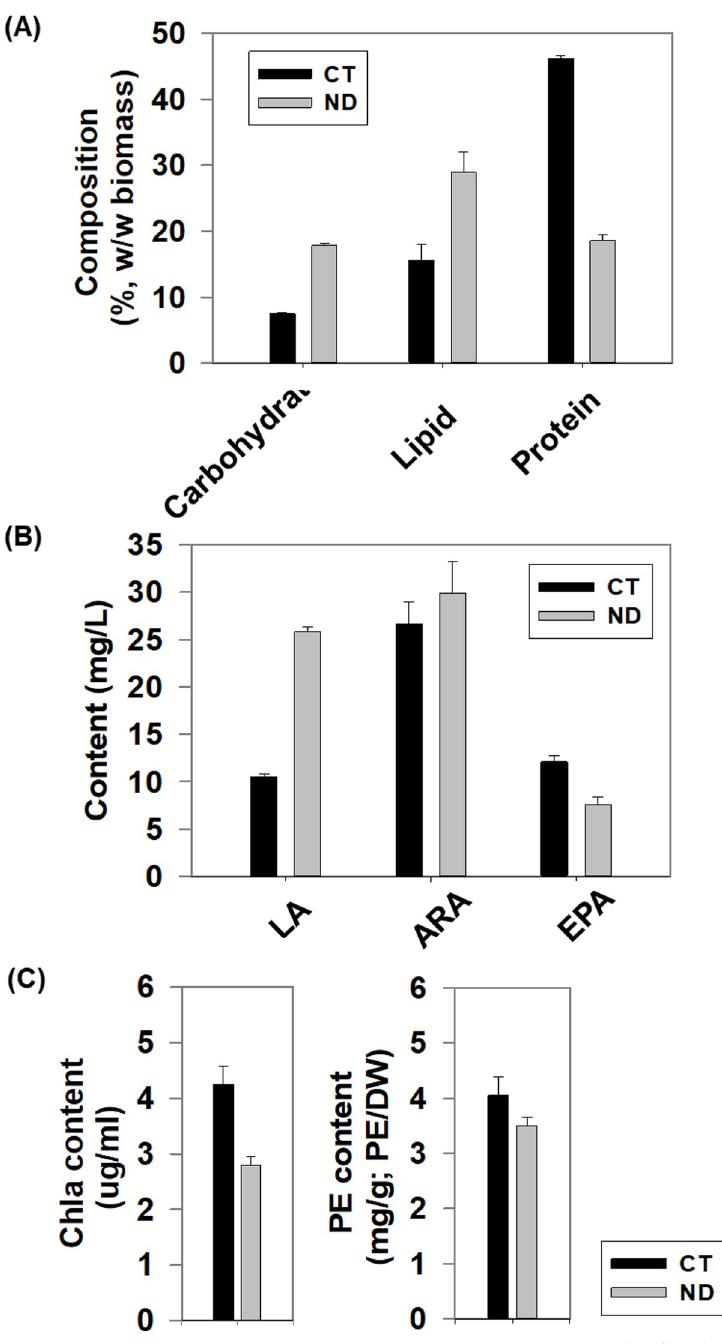
Fig 1. Physiological measurements of P . cruentum under CT and ND. ( A ) The of biochemical compositions of lipid, carbohydrate and protein at 72h under ND and under CT. ( B ) The contents of three key LC-PUFAs were detected. ( C ) The contents of Chla and PE were compared under CT and